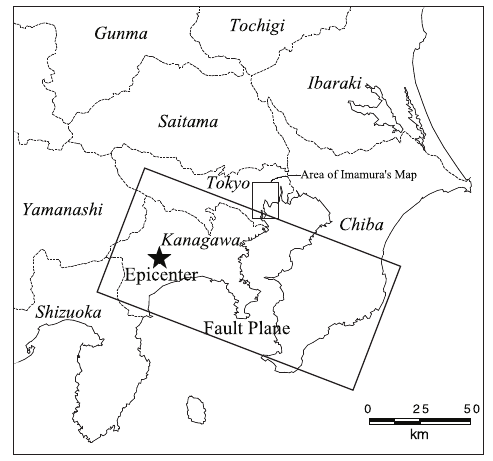
Fig. 3. Locations of epicenter and fault plane of the 1923 Kanto